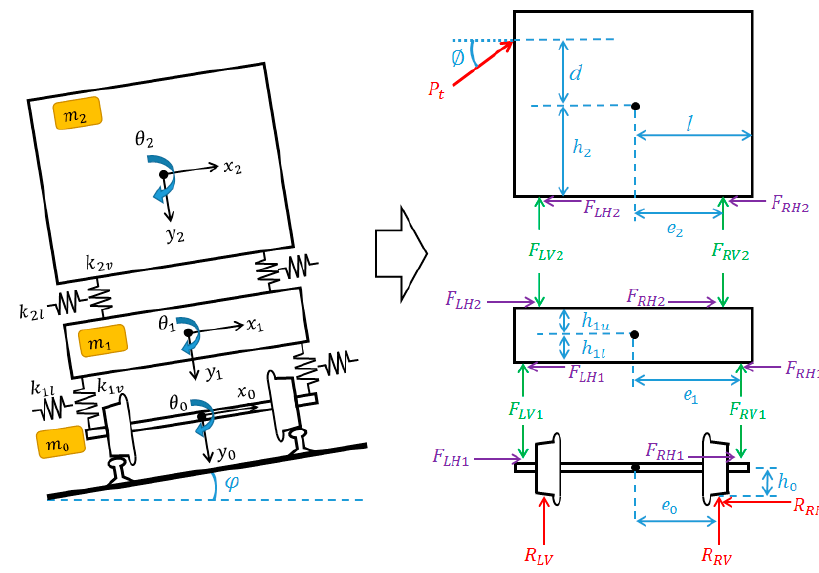
Figure 4. The free body diagram of a vehicle under a cross-wind.